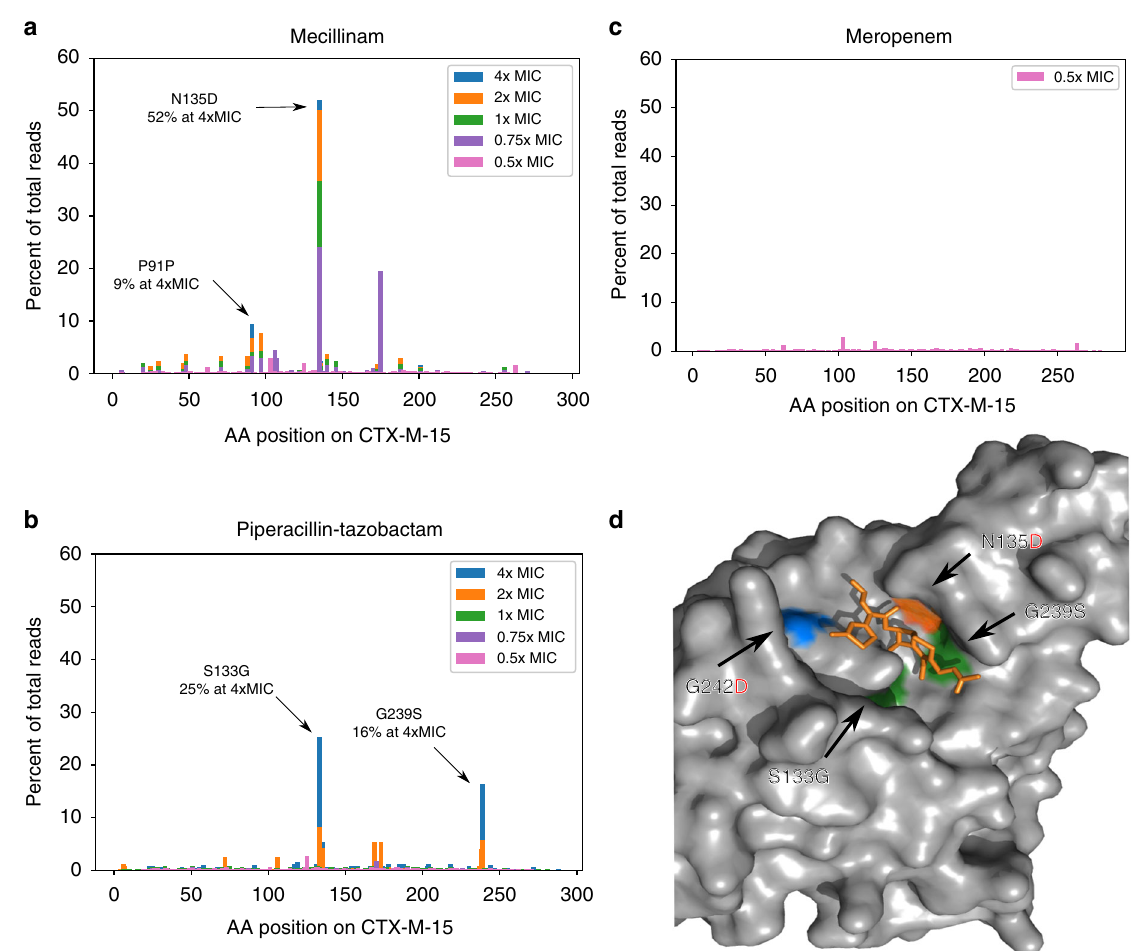
Fig. 1 Frequency of CTX-M-15 clones selected on antibiotics and position of mutations. A blaCTX-M-15 gene mutant library obtained by error-prone PCR was grown on different antibiotic concentrations (0.5 – 4 × minimal inhibitory concentration (MIC)), the resulting clones were sequenced, and the percentage of reads for each SNP is shown for: mecillinam ( a ), piperacillin – tazobactam ( b ), and meropenem ( c ). The CTX-M-15 wild-type (CTX-M-15 WT) MIC for mecillinam is 0.25 µ g/ml, for piperacillin – tazobactam is 16 µ g/ml, and for meropenem is 0.06 µ g/ml. d A 3D structure of the CTX-M-15-binding site with cefotaxime (orange) (PDB: 5FAP [https://www.rcsb.org/structure/5FAP]). Mutations providing high resistance against mecillinam: N135D (orange), against piperacillin – tazobactam: S133G and G239S (green), and amoxicillin – clavulanic acid (blue). Amino acid (AA) letters with uncharged side chains are written in black and negatively charged side chains in